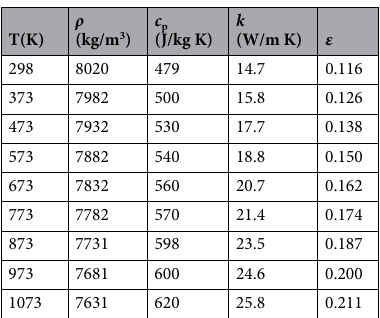
Table 4. Thermal properties of 304 stainless steel.